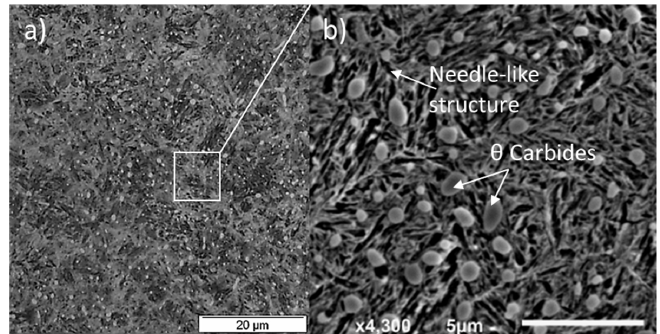
Figure 2. ( a ) Microstructure of martensitic bearing steel; ( b ) the needle-like structure containing pri- mary θ carbides, adapted from